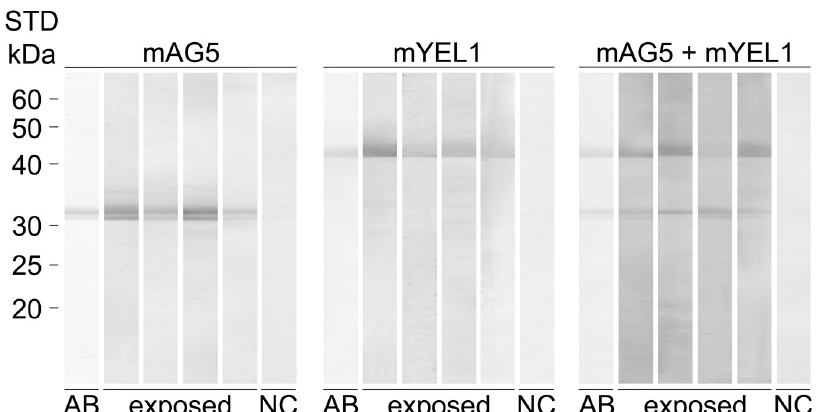
Fig 2. Antibody reaction against mYEL1, mAG5 and their combination on immunoblot. Recombinant mYEL1, mAG5, or both in equal amounts were run by SDS-PAGE under non-reducing conditions. Western blot analysis was performed for four human sera samples anti-recombinant proteins positive in ELISA (exposed) and one negative control serum (NC). AB stands for recombinant protein strip stained by amidoblack. Molecular weights (kDa) of standard (STD; BenchMark Protein Ladder, ThermoFisher Scientific) are indicated.